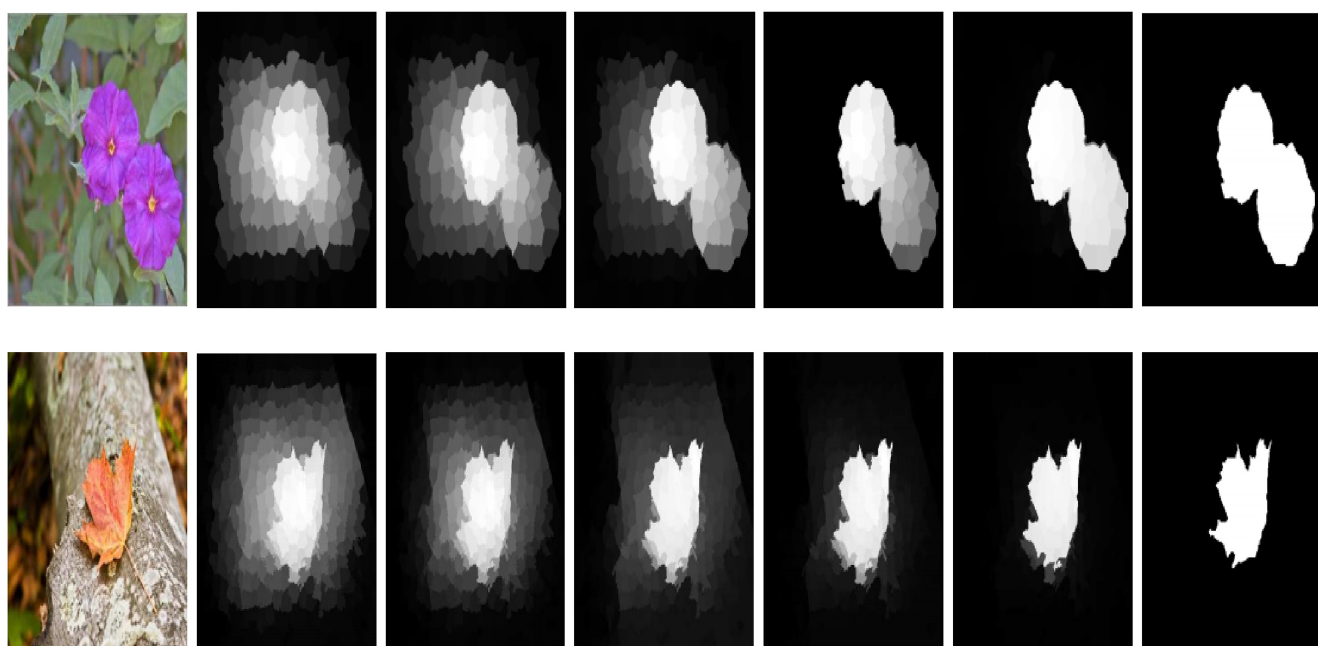
Fig 6. Our model complete transformation processes, the background part is diffuse as the iteration proceed, and at the end of iterations the process attains its ultimate saliency values. The results are similar but not identical to the original images and is therefore for illustrative purposes only.